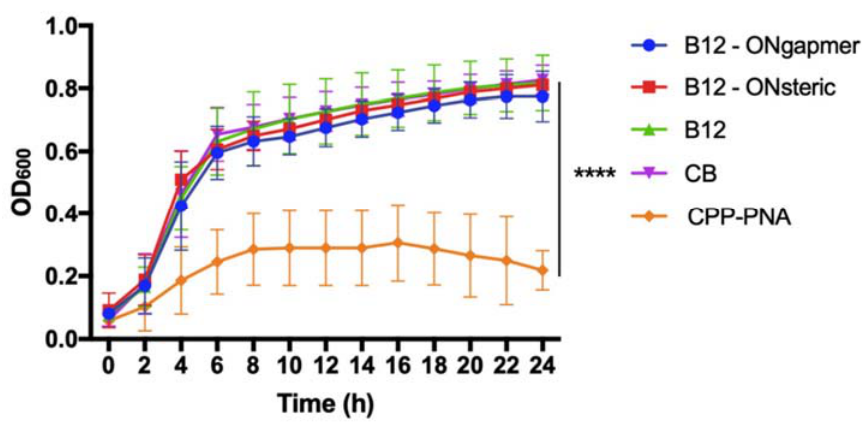
Figure 3. Growth of E. coli K12 in Davis minimal medium supplemented with B 12 -ASO gapmer , B 12 -ASO steric, and B 12 (at a concentration of 30 µ M). CB represents the bacterial growth control in medium without any supplementation. Growth inhibition of E. coli K12 using a cell-penetrating peptide con- jugated with an ASO composed of peptide nucleic acids (PNAs) (cell-penetrating peptides (CPP)- PNA) at a concentration of 30 μ M is also shown. Results from three independent experiments (using duplicates in each) are presented as mean values and respective standard deviations. Statistical dif- ferences are indicated when appropriate in * ( p ≤ 0.0001, **** ).